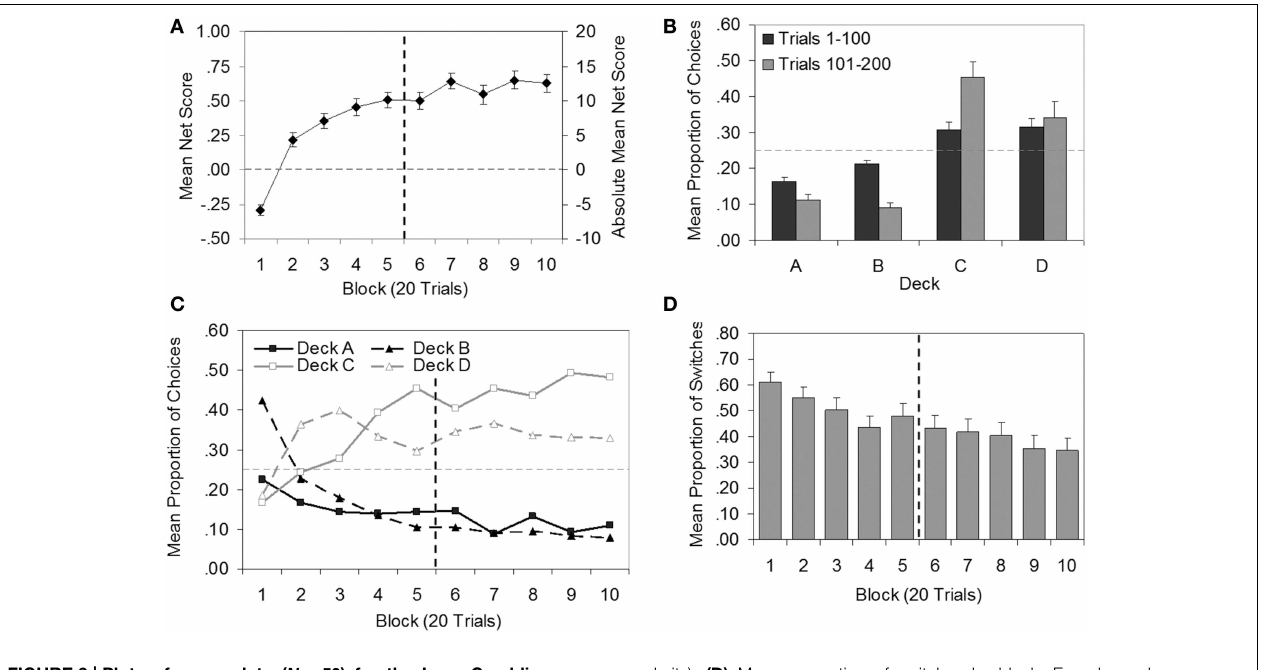
FIGURE 3 | Plots of group data ( N = 50 ) for the Iowa Gambling Task. (A) Mean net score by block (secondary axis displays absolute mean net score for comparison with previous literature). (B) Mean proportion of choices by deck for each 100-trial epoch. (C) Mean proportion of choices by block for each deck (error bars omitted for